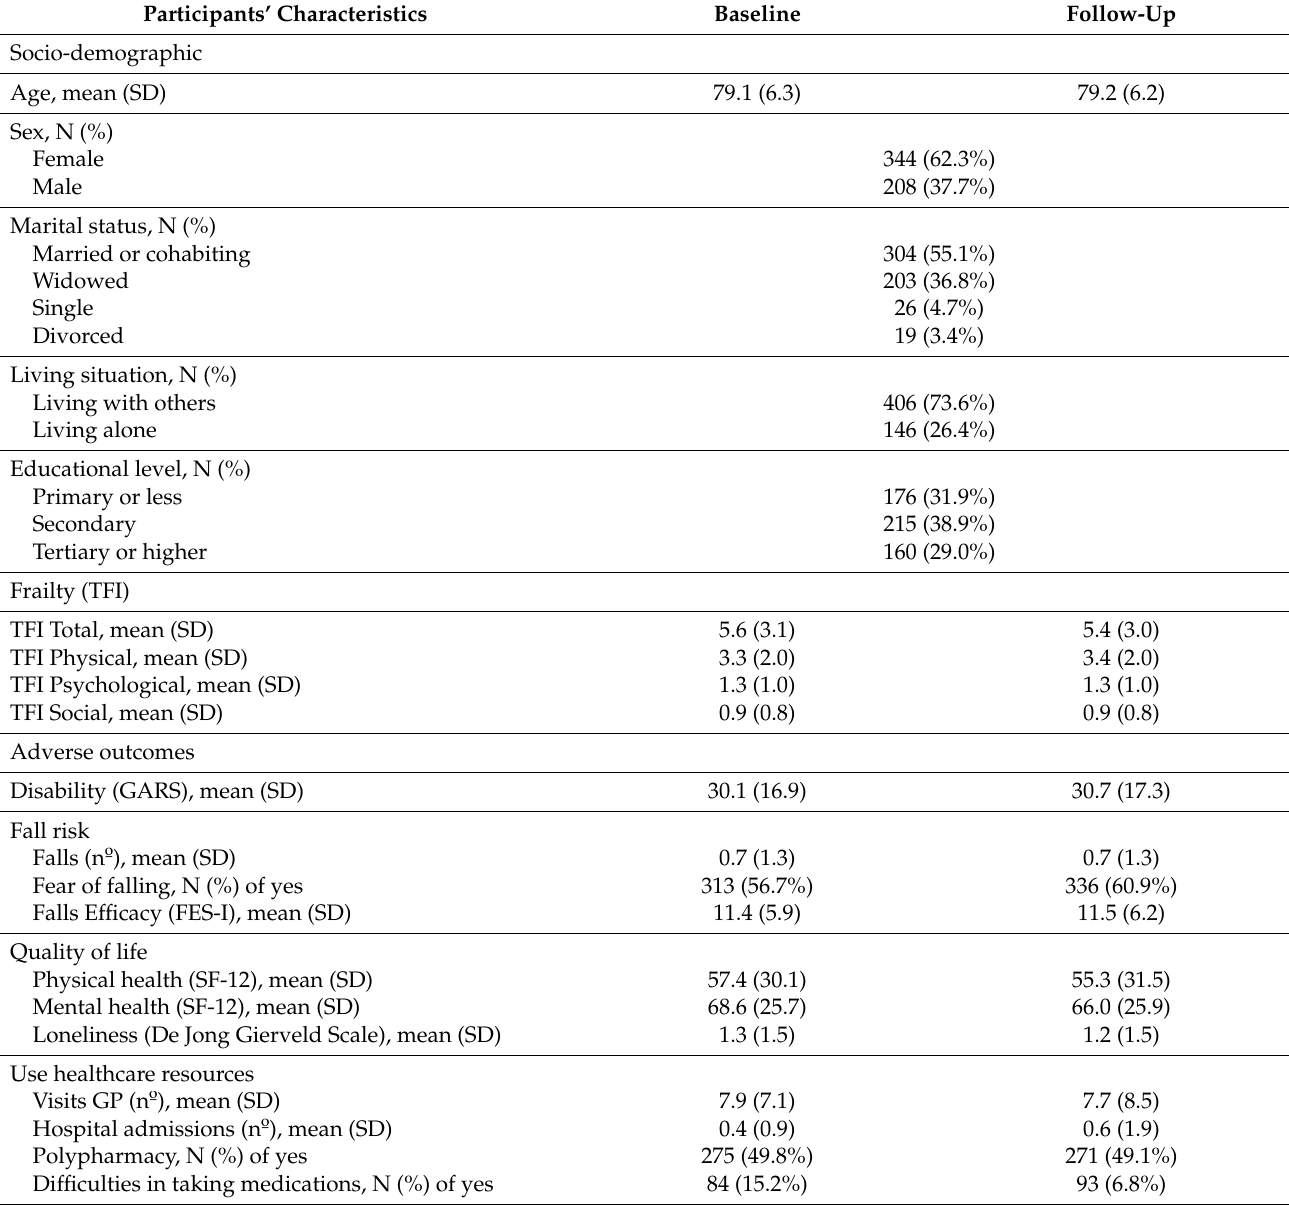
Table 1. Characteristics of the Participants (N = 552).